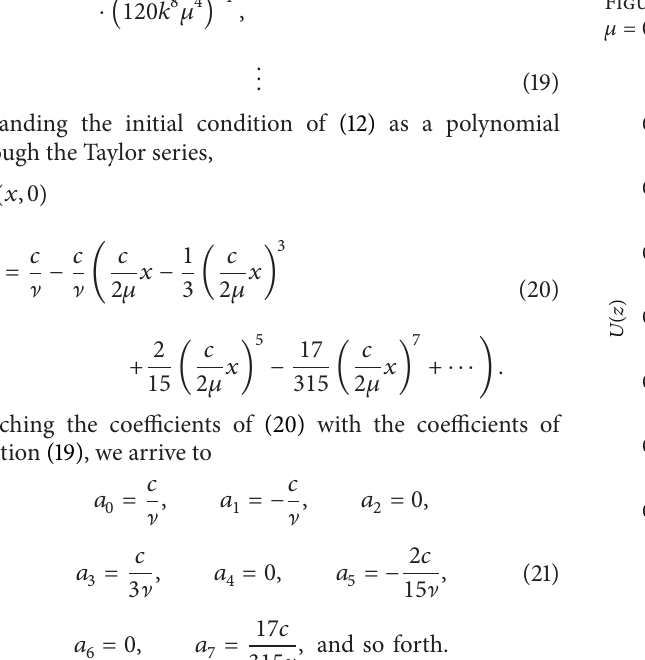
Figure 6: Trajectories of the approximate solution of the Burgers- type equation, (12), with ] = 10 , 𝜇 = 0.1 , and 𝑐 = 0.1 , for 𝑥 = 0.9